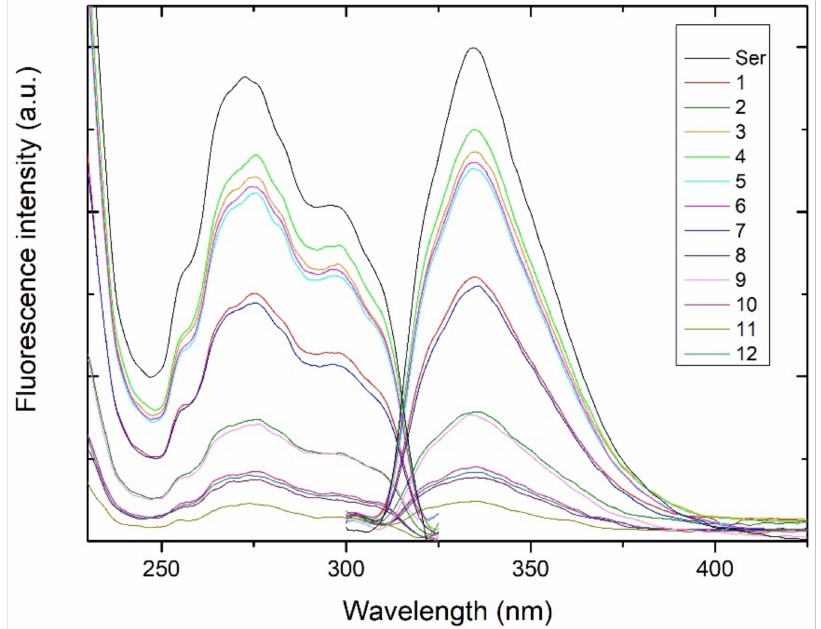
Figure 4. Fluorescence excitation and emission spectra of serotonin and the isolated compounds 1–12 from lemon seeds in the HPLC solvent. Further details are given in the Materials and Methods